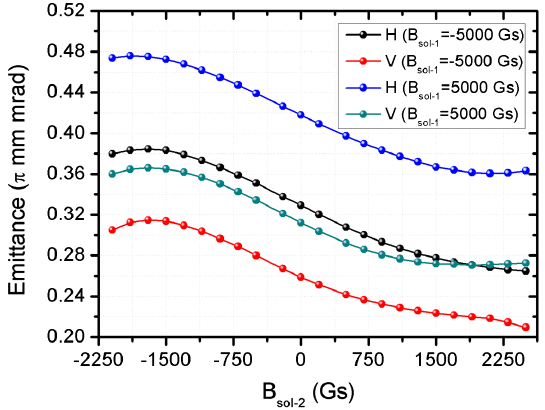
FIG. 7. Simulated beam emittances versus both field strengths and polarities of the two solenoids after the ion source.